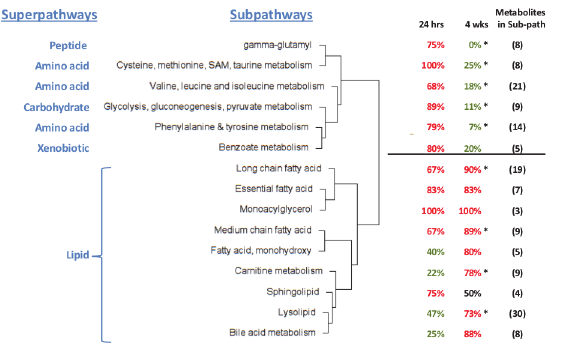
Figure 3. Dendrogram of 15 subpathways whose metabolites ’ plasma levels changed coordinately. Shown is the hierarchical clustering of subpathways by mean Manhattan distance score, which describes the similarity in the direction of change (higher or lower) of metabolites of a subpathway in the eight comparisons of AggE vs. Ctrl and 24 hrs vs. 1.5 or 4 wks. Also shown for each subpathway is the percentage of metabolites higher (red) or lower (green) in AggE vs. Ctrl mice at 24 hrs and 4 wks after the 10-day stressor. The distance means for the lipid and non-lipid branches of the dendrogram were 3.1 ( p = 1E-04) and 3.07 ( p = 1E-04). Asterisks indicate the subpathways also determined by exact binomial test to have more metabolites lower or higher in AggE vs. Ctrl.